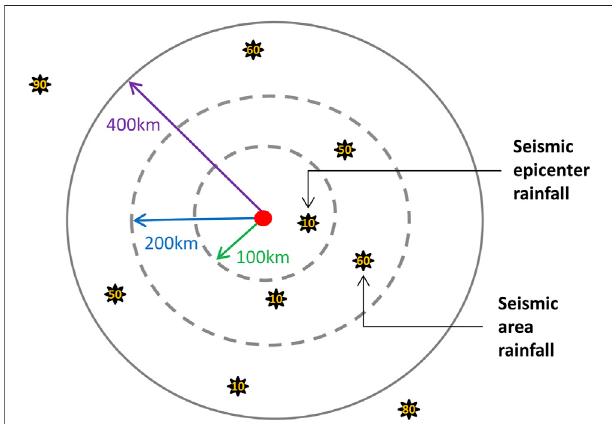
FIGURE 1 | Schematic diagram of the seismic epicenter rainfall and seismic area rainfall for an M s ≥ 7.0 earthquake. The red dot represents the epicenter and thethree gray dashed circles denote thein fl uence area forM s ≥ 6.0, M s ≥ 7.0 and M s ≥ 8.0 earthquakes, respectively. The black stars show the locations of the meteorological stations and the daily precipitation (units: mm) is overlaid in gold numbers.